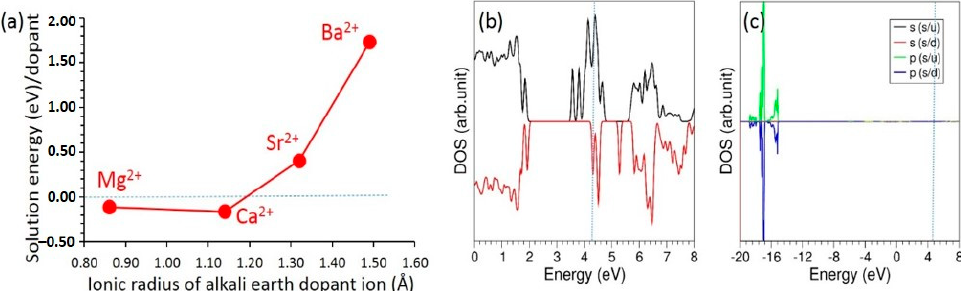
Figure 4. ( a ) Solution energies of alkali earth dopants on the Zn site, ( b ) total DOS plot of Ca-substituted Zn 3 V 4 (PO 4 ) 6 , and ( c ) DOS plot associated with the Ca.